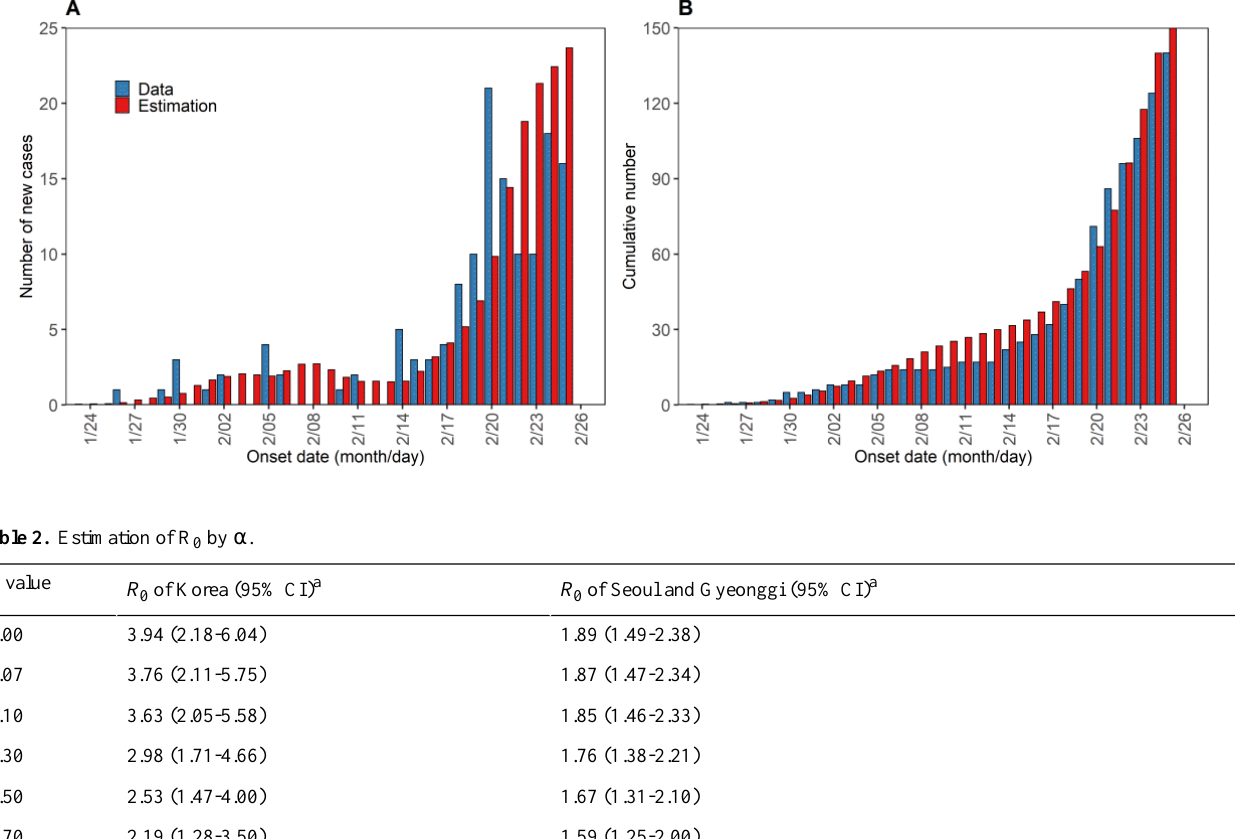
The R was calculated for α =0.07 and the daily epidemic curves t of imported (green) and local (gray) cases and the R (blue curve) in the Seoul and Gyeonggi regions are shown in Figure 6. On March 11, 2020, when the WHO declared